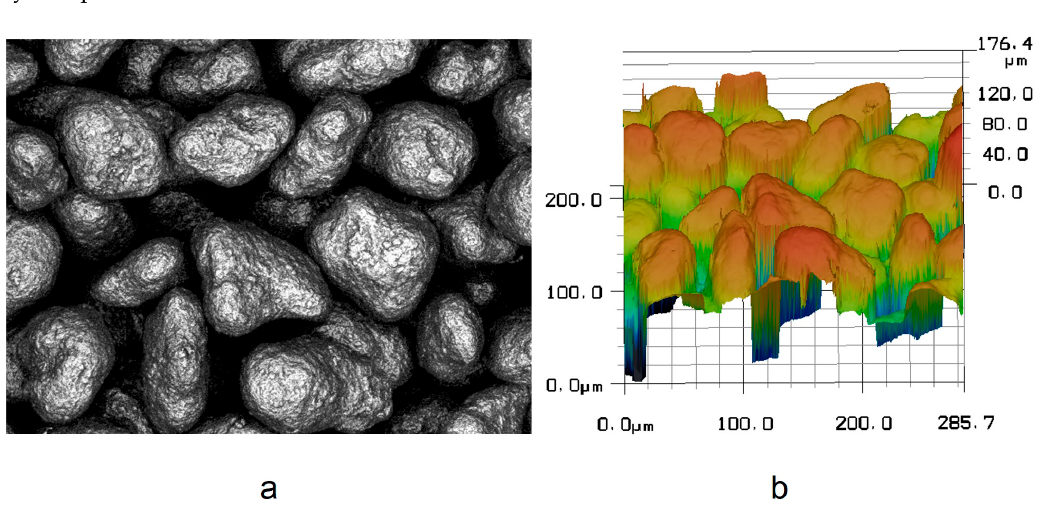
Figure 10. ( a ) Excerpt of an LSM scanning process and ( b ) Excerpt of the surface topology data